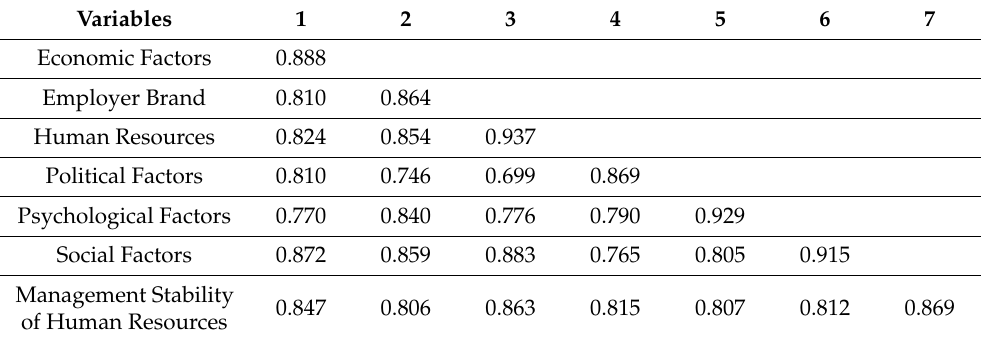
Table 2. Convergent validity (Source: authors).